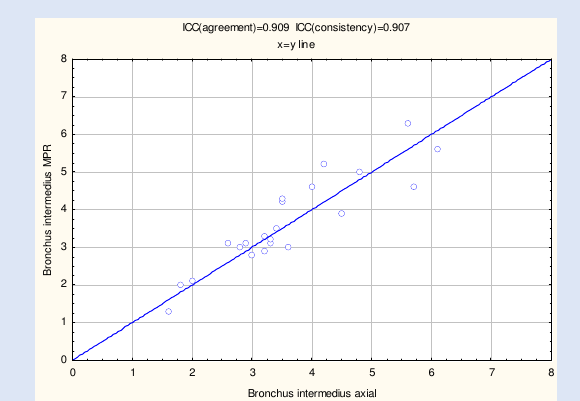
Graph 3. Comparison of axial measurements v. measurements after MPR in the bronchus intermedius  ICC(agreement)=0.909 ICC(consistency)=0.907 x=y line